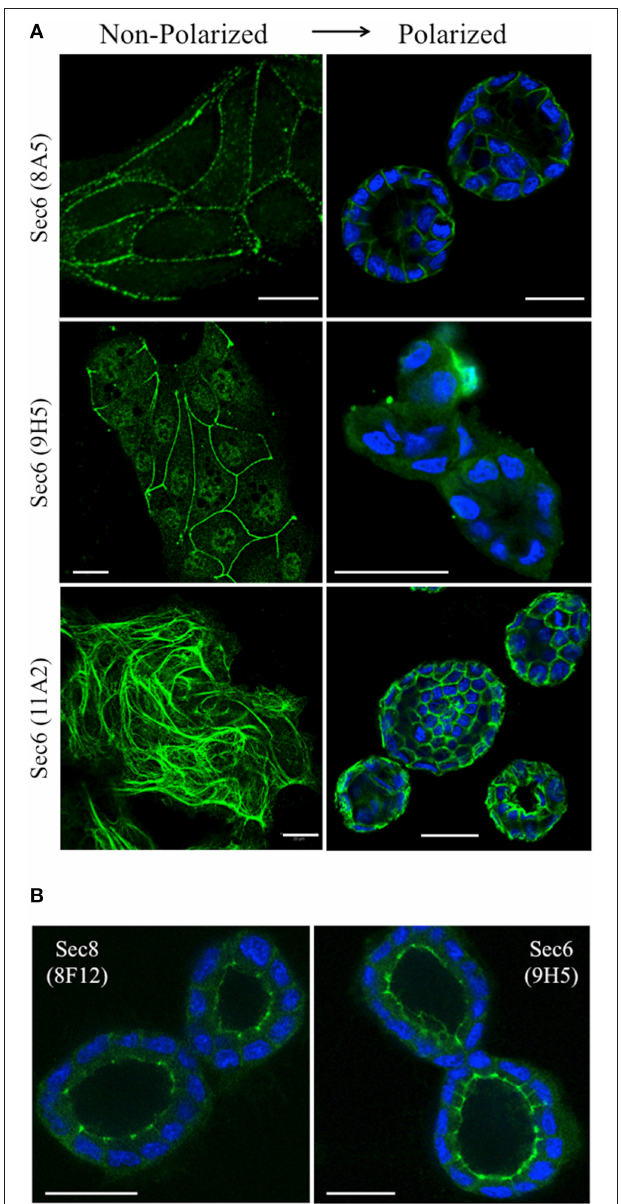
FIGURE 8 | Sec6 epitopes redistribute during epithelial polarization. (A) MDCK cells were cultured as sub-confluent colonies on collagen-coated glass coverslips (non-polarized) or seeded in Matrigel and grown for 4 days (polarized). Cultures were fixed in 100% methanol and labeled with indicated anti-Sec6 mAbs (green). Polarized cultures were co-labeled with DAPI (blue). Bar = 20 µ m. (B) MDCK cells were seeded in Matrigel and grown for 4 days. Cultures were either fixed in 100% methanol (left) or pre-extracted with 1% Triton X-100 before methanol fixation (right), and labeled with indicated antibodies (green) and DAPI (blue). Bar = 20 µ m.